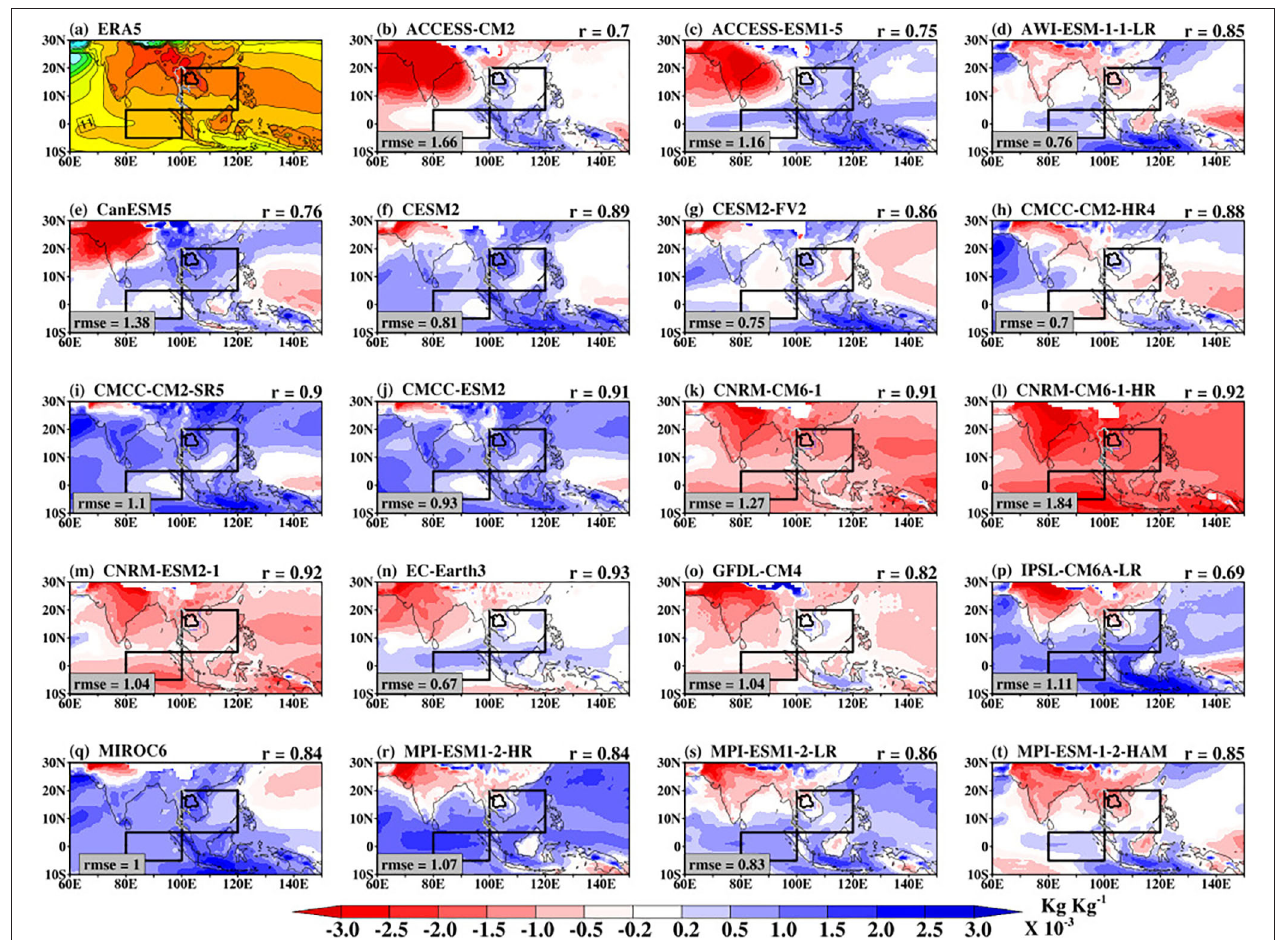
FIGURE 14 | The bias in the simulated monthly mean specific humidity at 850 hPa (b–t) with reference to ERA5 (a) during May–October 1997–2014. The mean pattern of ERA5 specific humidity at 850 hPa is indicated for reference. The pattern correlation (r) and the root mean squared error (rmse) values between the simulated patterns and that of ERA5 in Supplementary Figure 2 are indicated for